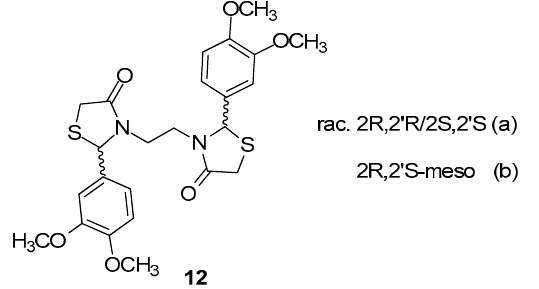
Figure 15. Chemical structures of racemic mixtures ( a ) and mesomeric ( b ) forms of 3,3 ′ -(1,2-ethanediyl)-bis[2-(3,4-dimethoxyphenyl)-4-thiazolidinone 12 .